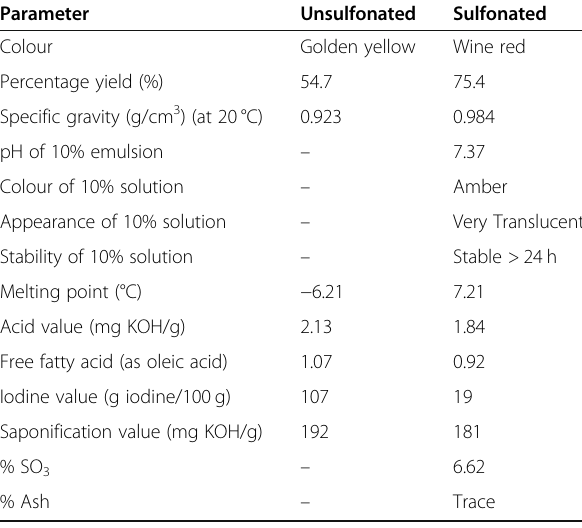
Table 3 Physicochemical properties of unsulfonated and